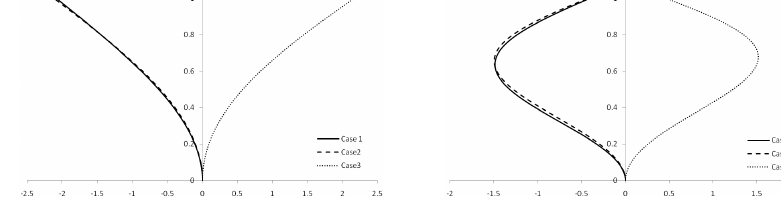
Figure 7. Modeshapes for the first mode – exponential variation.